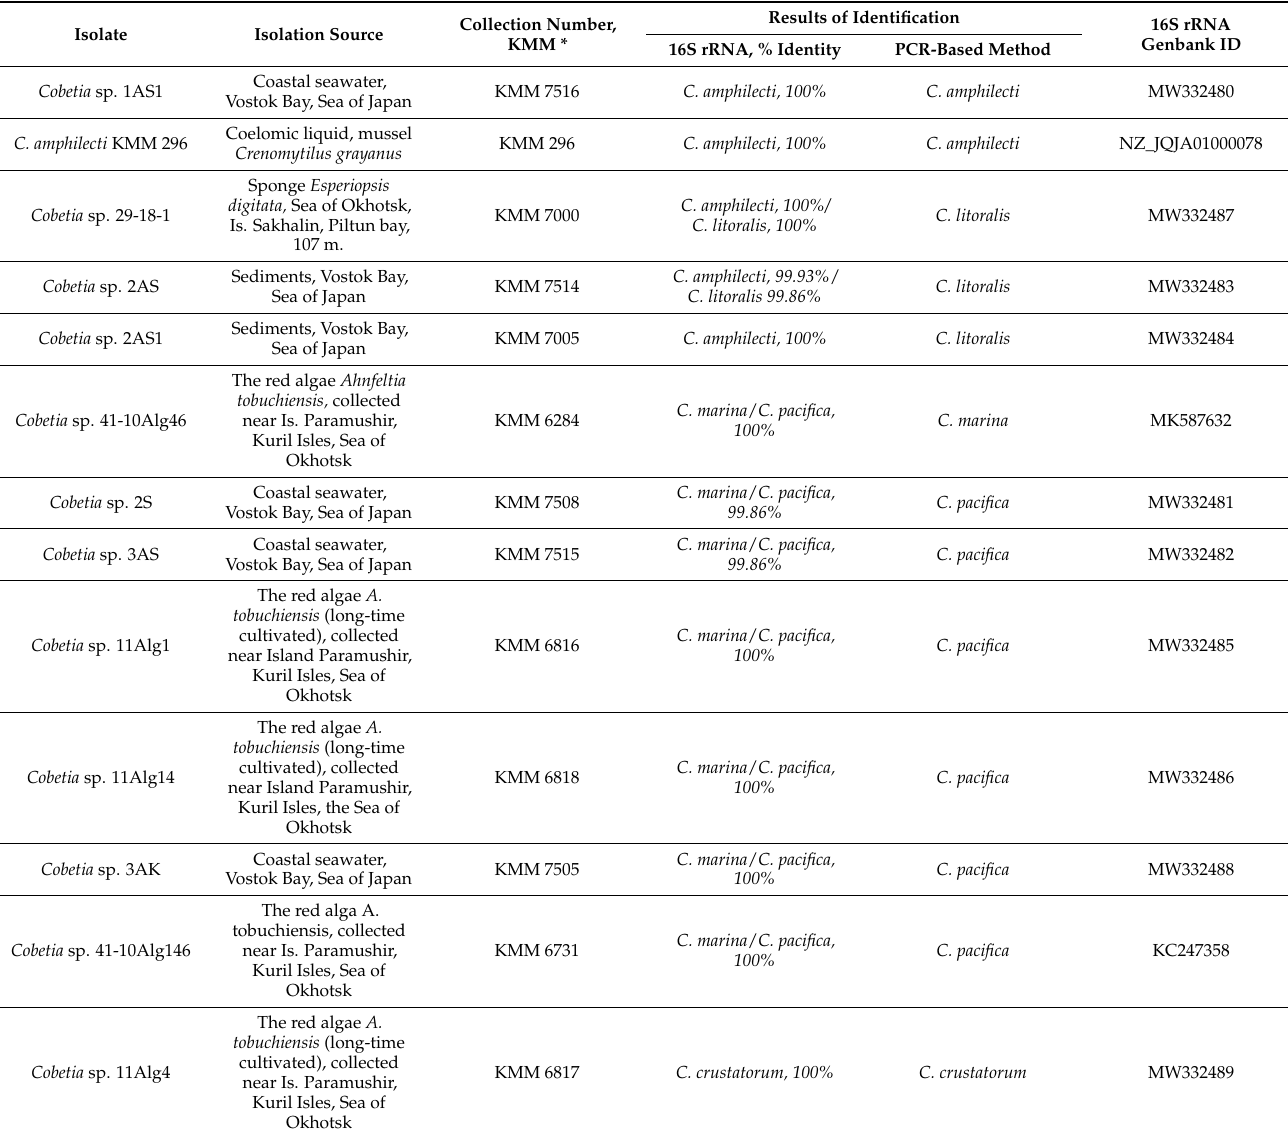
Table 1. The species identification of Cobetia isolates from the Pacific